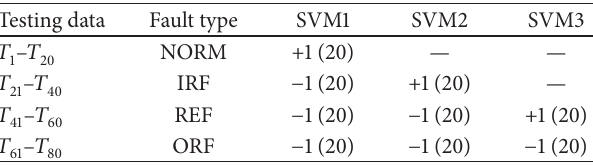
Table 1: The SVM-classifier outputs of testing data with feature vector refined by LS.